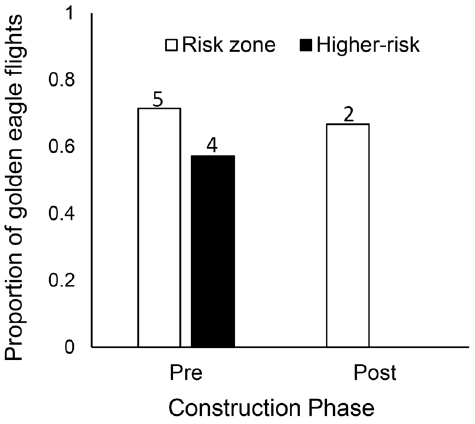
Figure 7. Proportion of risk zone and higher-risk crosses under tailwinds. Proportion of golden eagle ridge-top crosses within risk zone ( # 150 m above ground) and of higher-risk (within risk zone at winds above turbine cut-in speed 6.8 km/h) under tailwind conditions during pre- and post-construction. Values above bars represent sample